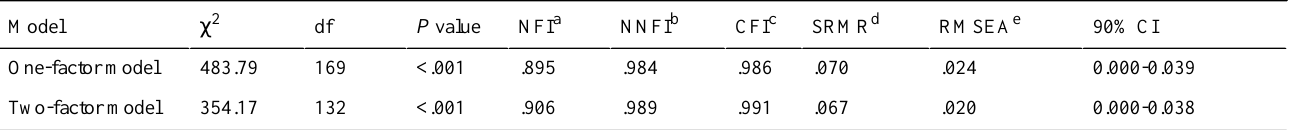
Table 5. Fit indices for the one-factor and two-factor